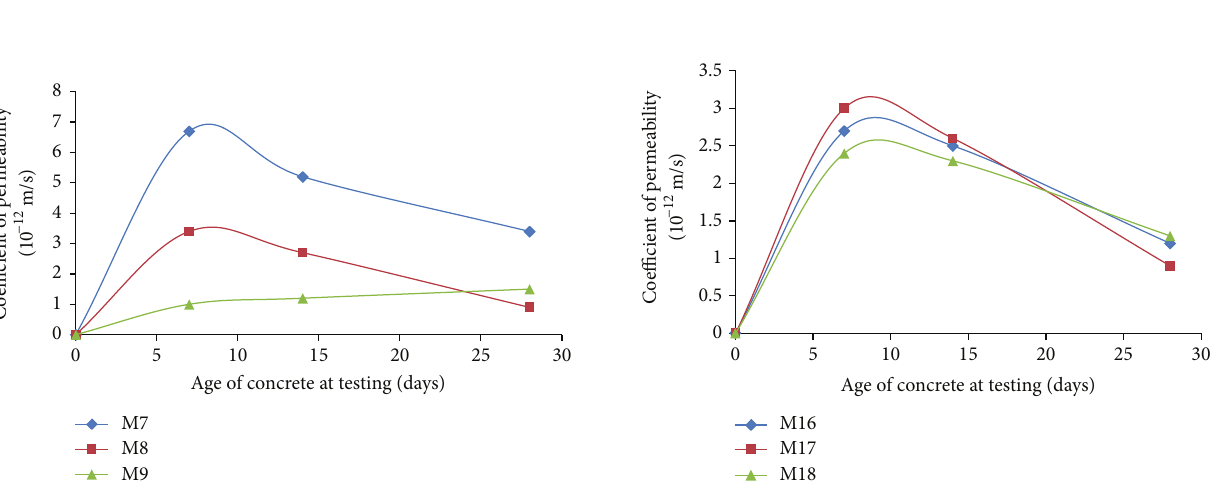
Figure 10: Effect of quarry dust on the cracked permeability of concrete with 400 kg/m 3 of